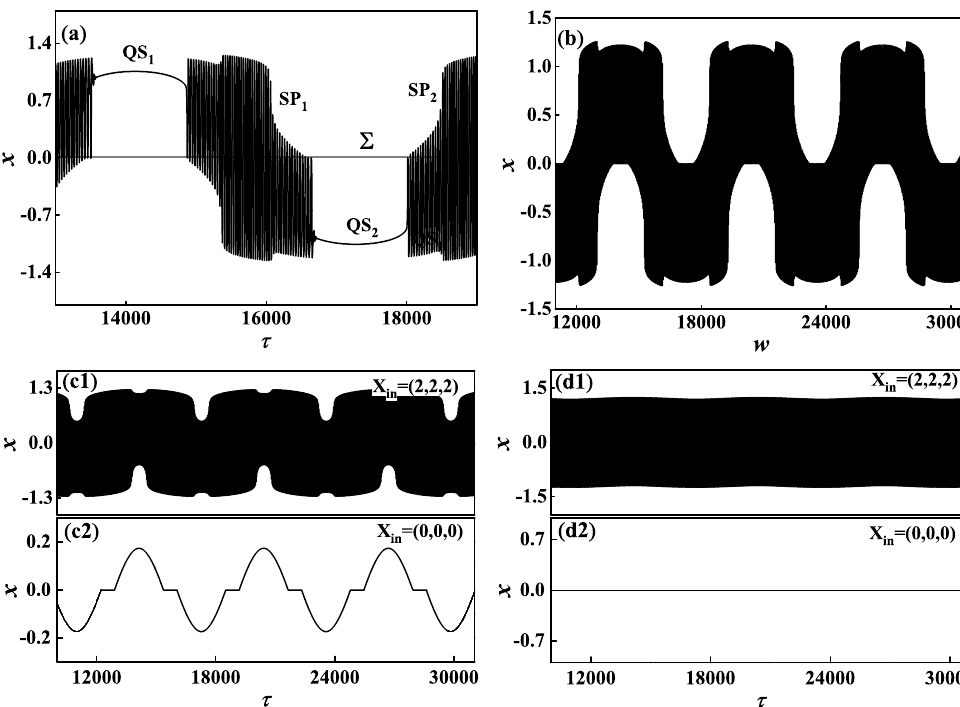
Figure 5. Waveforms of System (5) with different amplitudes. ( a ) Mode A with W = 0.8; ( b ) mode B with W = 0.655; ( c1 , c2 ) mode C with W = 0.3; ( d1 , d2 ) mode D with W =